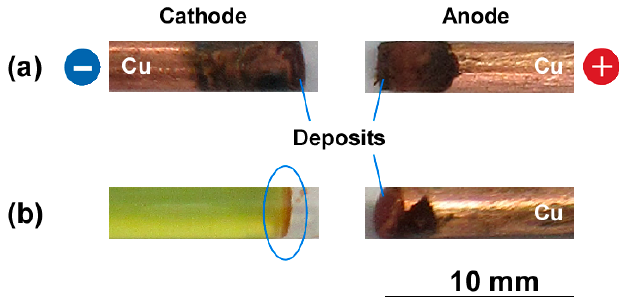
Figure 6. ( a ) Images of the Cu cathode and anode after applying 2 V across the sample tube for 100 h. ( b ) Images of the gel sample (left) after contacting a Cu rod (right) without voltage application for 100 h. Reddish–brown deposits were observed on these Cu rods, as well as at the gel boundary (in the ellipse). A scale bar is provided at the bottom of the